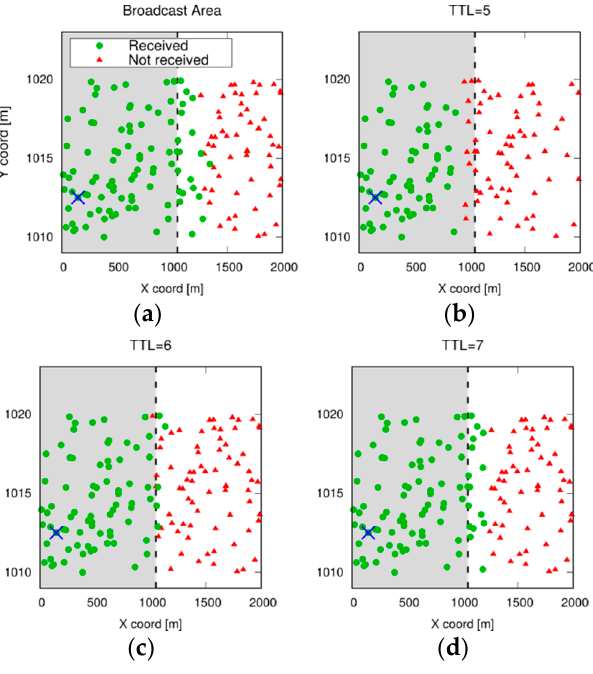
Figure 9. Target area vs. TTL.